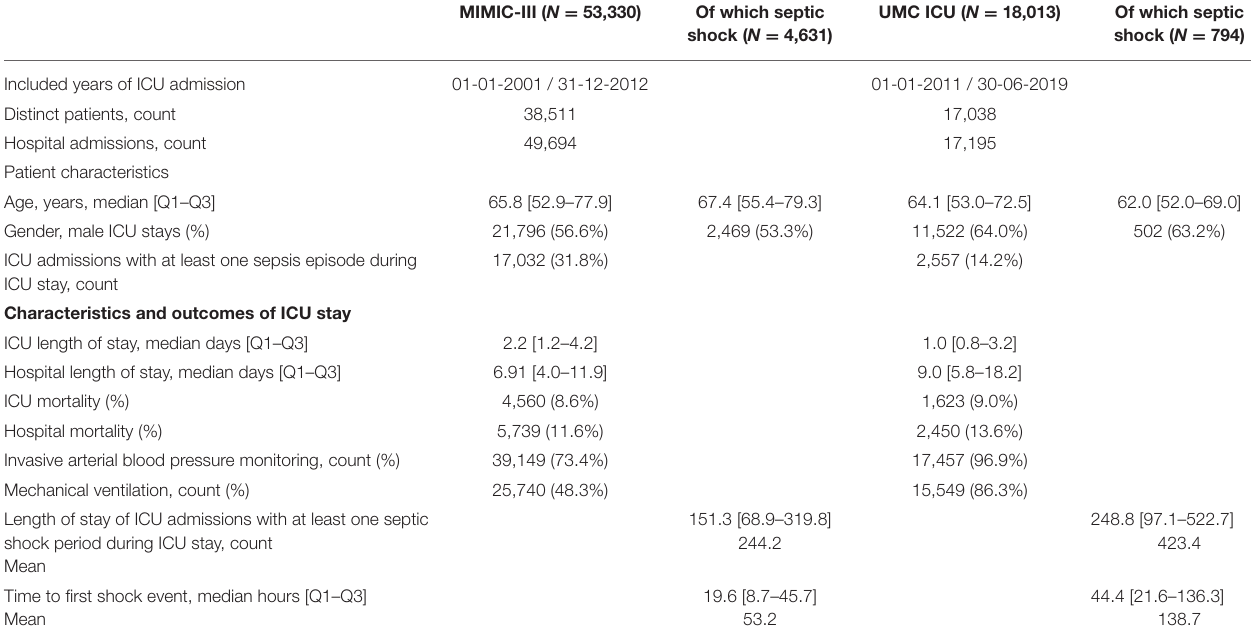
TABLE 1 | Characteristics of intensive care unit